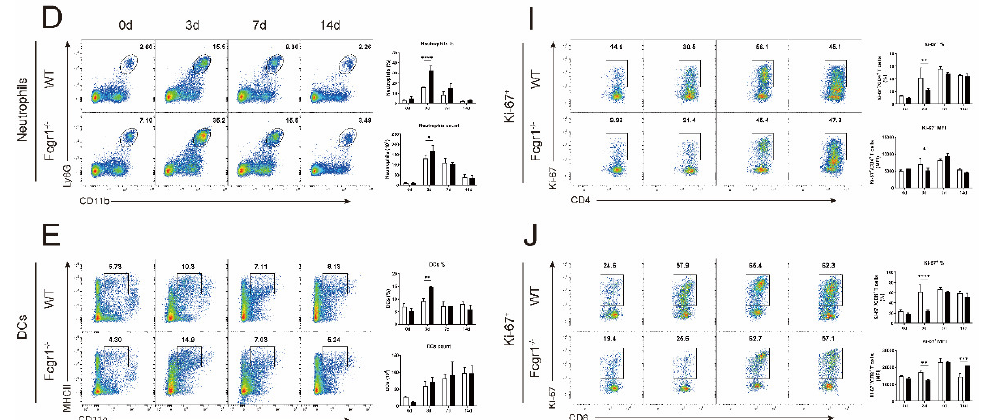
Figure 3. Altered numbers of innate and adaptive immune cells in Fcgr1 −/− mice after C. muridarum infection. The lung single cells of WT and Fcgr1 −/− mice on days 0, 3, 7, and 14 p.i. were prepared, and the infiltrations of innate and adaptive immune cells (gated as described in Supplementary Figure S1) were examined by flow cytometry. Representative flow cytometric plots ( left panel ), percentages ( top right panel ), and total numbers of (bottom right panel) of Ly6C hi monocytes ( A ), macrophages ( B ), neutrophils ( D ), DCs ( E ), CD3 + T cells ( F ), CD4 + T cells ( G ), CD8 + T cells ( H ), Ki−67 + CD4 + T cells ( I ) and Ki−67 + CD8 + T cells ( J ) are shown. ( C ) The lung cryosections at day 3 p.i. were stained by anti-F4/80 for macrophages (green), and nuclei were stained with DAPI (blue), representative immunostaining captured by fluorescence microscopy in ×200 magnification. Data are represented as means ± SD from n = 3–5 per group, representative of one of three independent experiments. Statistical significances of differences are determined by two-way ANOVA. * p < 0.05, ** p < 0.01, *** p < 0.001, **** p < 0.0001.